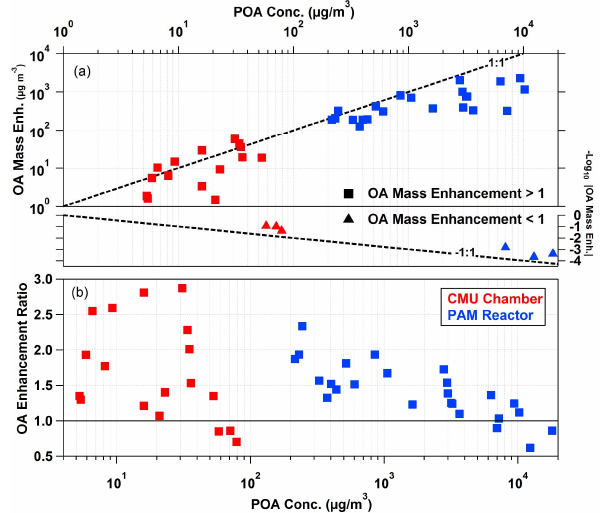
Fig. 8. OA enhancement as a function of unprocessed OA for all fu- els, with CMU’s mobile air-quality laboratory smog chamber (red), as reported in Hennigan et al. (2011), and flow reactor (blue). (a) OA mass enhancement (aged minus unprocessed) vs. POA (unpro- cessed). To plot data with logarithmic y axis, fuels whose aged smoke resulted in net mass loss are shown as the negative log of the absolute value of the difference between aged and unprocessed smoke, and plotted on a separate y axis. (b) OA enhancement ratio (i.e., relative enhancement) vs. unprocessed